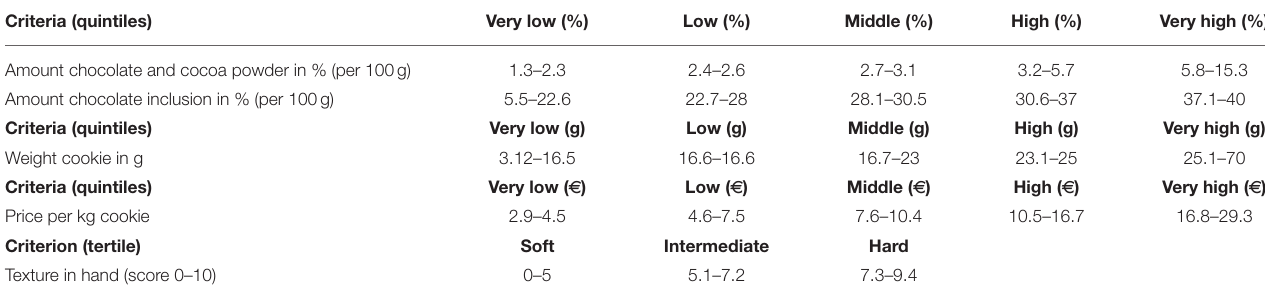
TABLE 1 | Rank calculation of the quintiles and tertile of the subgroups. Criteria (quintiles) Very low (%) Low (%) Amount chocolate and cocoa powder in % (per